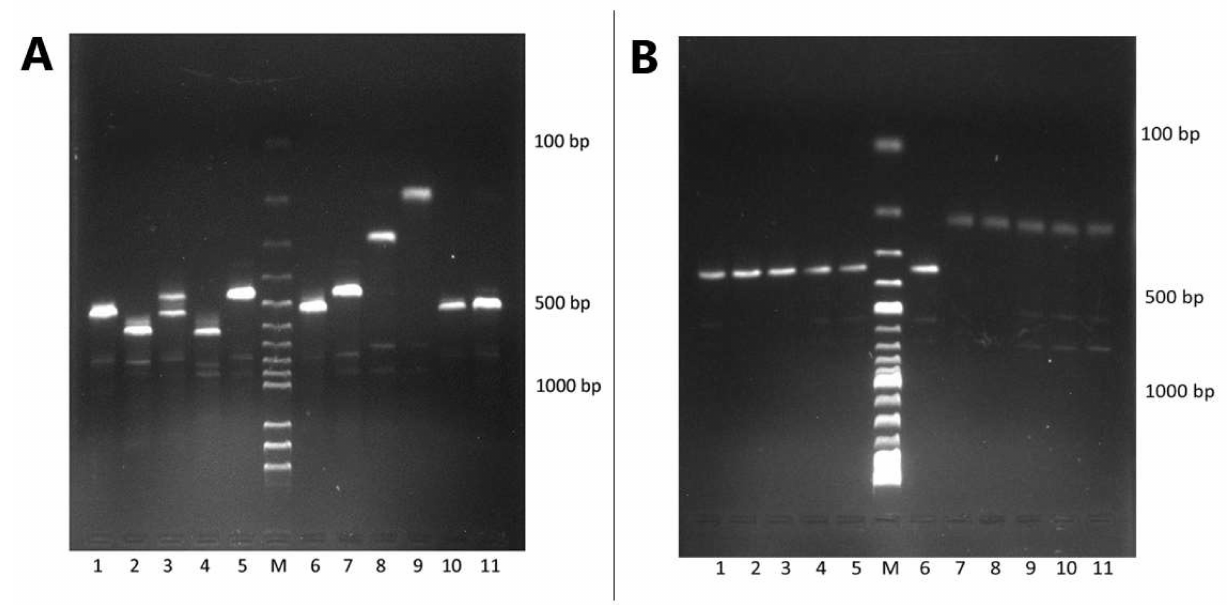
Figure 3. Rapid genotyping of human rotavirus: ( A ) G-typing multiplex PCR. Lanes: 1, 6, 10,